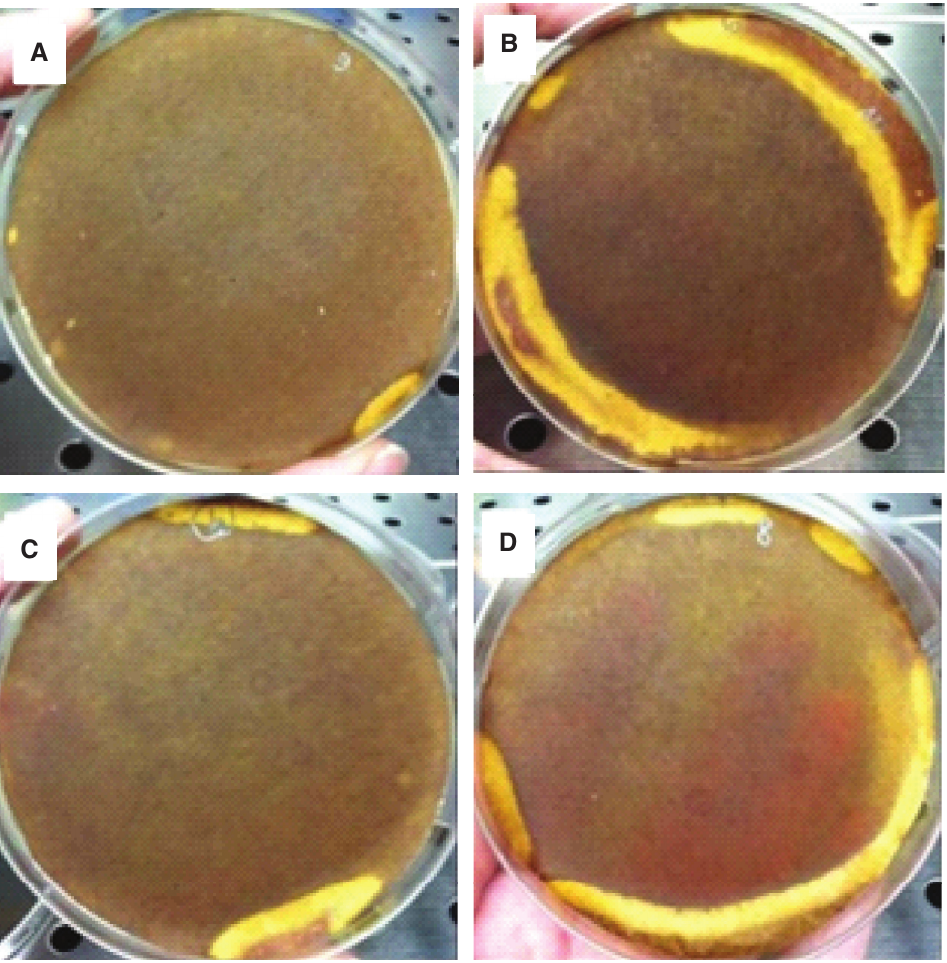
Figure 6: Cellulose samples sonicated in a yellow colored solution containing AgNPs for (A) 3 min, (B) 5 min, (C) 7 min, and (D) 10 min, showing antibacterial